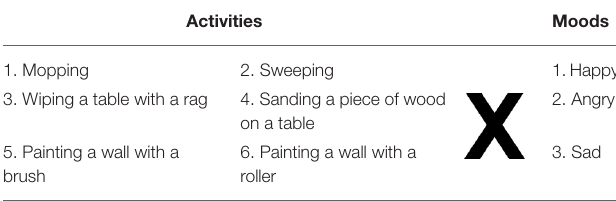
TABLE 1 | Activities and moods recorded in the motion capture